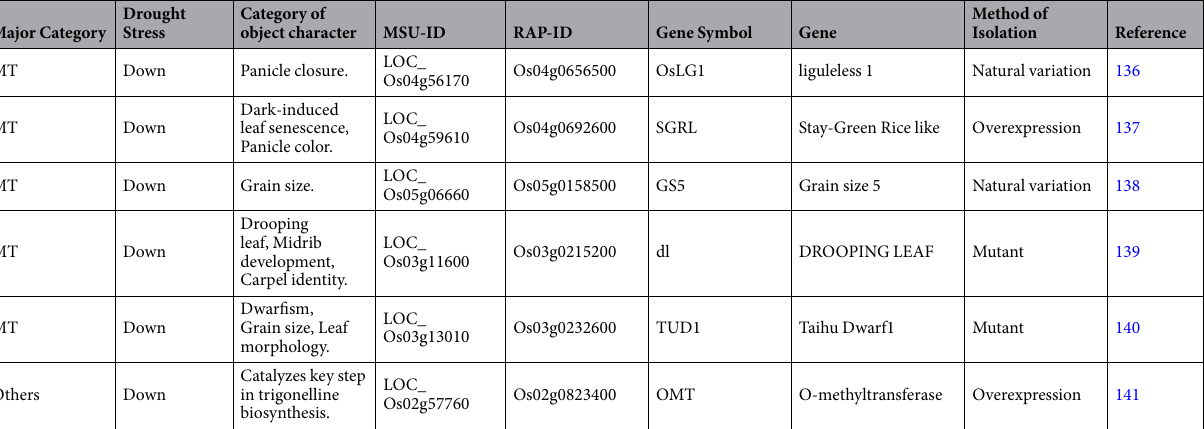
Table 1. Information about functionally characterized genes from OGRO database, showing diurnal and drought-responsive patterns of expression. R or T, resistance or tolerance; MT, morphological trait; PT, physiological trait; Up, candidate gene up-regulated under drought; Down, candidate gene down-regulated under drought; Method, type of mutant used in referenced study. expression was approximately nine times in the stressed plants than in the MOCK. Meta-analysis also showed that this gene followed a diurnal pattern, with expression being highest at the end of the night and lowest at the end of the day (Fig. 2a). For the latter approach, we constructed promoter-GUS reporter gene vectors under the control of the LOC_Os10g42160 promoter. Using T1 transgenic plants that expressed GUS, we tested inducible patterns under drought and found that, as we expected, GUS reporter activity was significantly stimulated by 6 h of stress (Fig. 2b). We also conducted quantitative RT-PCR analyses and confirmed that LOC_Os10g42610 expression was approximately three times higher in stressed plants than in the MOCK control. Expression was again strongest at the end of the night and lowest at the end of the day (Fig. 2b). The expression patterns of additional drought-inducible and diurnally rhythmic candidate genes encod- ing glycogen branching enzyme (OsSBE3, LOC_Os02g32660 ), Os β -amylase3 (OsBAM3, LOC_Os03g04770 ), Os β -amylase2 (OsBAM2, LOC_Os10g32810 ), Os β -amylase5 (OsBAM5, LOC_Os10g41550 ), neutral/alkaline invertase ( LOC_Os04g33490 ), and sucrose synthase ( LOC_Os03g22120 ) were also validated (Figures S4 and S5). As expected, they all exhibited diurnal rhythmic pattern and drought induced expression. These expression data further enhance the fidelity of the global transcriptome data used in this study. Gene Ontology enrichment analysis reveals the significance of water-stress responses asso - ciated with diurnal regulation. We performed Gene Ontology (GO) enrichment analysis with the Rice Oligonucleotide Array Database (ROAD; www.ricearray.org/index.shtml) to identify the biological roles of can- didate genes that are both drought-responsive and have a diurnal rhythm of expression. The GO terms were evaluated according to two thresholds ( ≥ two-fold enrichment and P-value < 0.05) 39 . In all, 19 terms were sig- nificantly enriched for 403 genes. Among them, 15 were related to drought stress or diurnal rhythm (Fig. 3a, Table S4). Several of those terms could be organized into categories for carbohydrate metabolism, transcription and translation, transport, protein process, and auxin pathway. Highly overrepresented terms, such as those for embryo development (GO:0009790; by 55.8-fold), response to water (GO:0009415; by 20.6), starch biosynthetic process (GO:0019252; 12.4), polysaccharide catabolic process (GO:0000272; 10.9), glycogen biosynthetic process (GO:0005978; 9.3), and carbohydrate metabolic process (GO:0005975; 2.3) indicated that these biological pro- cesses were more likely associated with up-regulated drought responses and diurnal rhythms. In total, 20 GO terms were enriched for 363 genes that were down-regulated by drought and also expressed diurnally. These terms covered categories for organ development, light reaction, carbohydrate metabolism, and transport (Fig. 3b, Table S5). Leaf development (GO:00048366; by 39.2-fold), flower development (GO:0009908; by 10.3), chlorophyll biosynthetic process (GO:0015995; 14.0), photosynthesis light harvesting (GO:0009765; 11.5), glycine catabolic process (GO:0006546; 28.0), cellular carbohydrate metabolic process (GO:0044262; 10.9), malate metabolic process (GO:0006108; 8.5), extracellular polysaccharide biosynthetic process (GO:0045226; 8.5), and tricarboxylic acid cycle (GO:0006099; 5.9) appeared to be important participants in the potential cross- talk between the diurnal cycle and drought-responsive